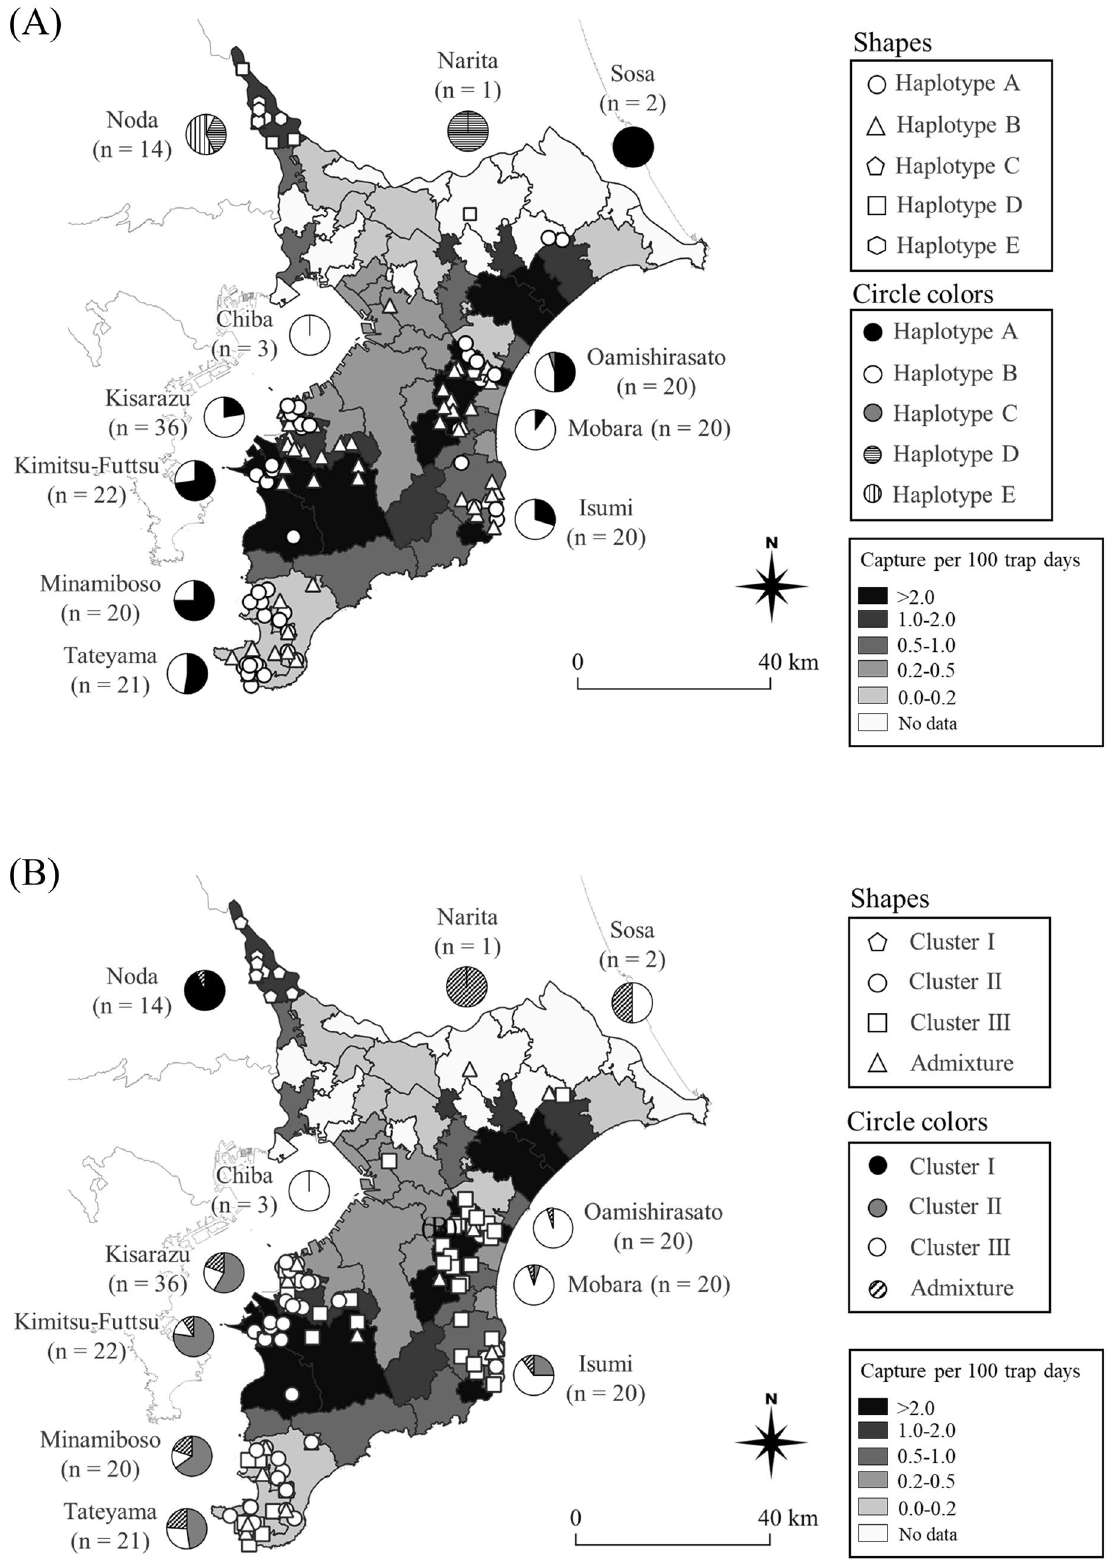
Figure 3. The background maps of ( A,B ) show the distribution of raccoons in Chiba prefecture, Japan in 2017. The maps are based on the CPUE (captures per 100 trap days) value in each administrative district (Chiba prefecture unpublished). ( A ) The distribution and the frequency of haplotypes observed in Chiba prefecture, Japan. ( B ) The frequency and the distribution of clusters (K = 3) in each district groups in Chiba prefecture, Japan. The maps in ( A,B ) were created by using Microsoft Power Point office 365 and QGIS ver. 3.4.4 (https:// qgis. org/ en/ site/ forus ers/ downl oad.